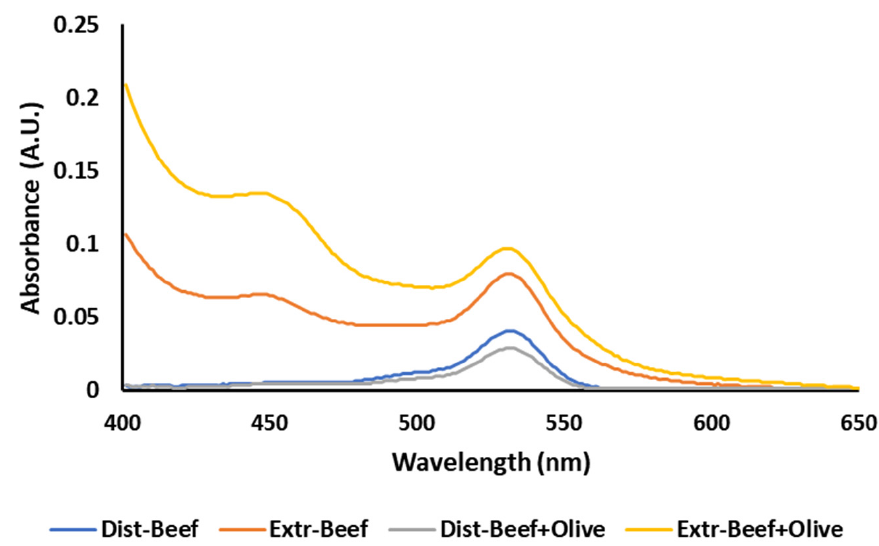
Figure 4. Absorbance spectra of the steam distillation (Dist) and the modified extraction (Extr) TBA method in plain ground beef and ground beef with 2% added olive leaf extract.